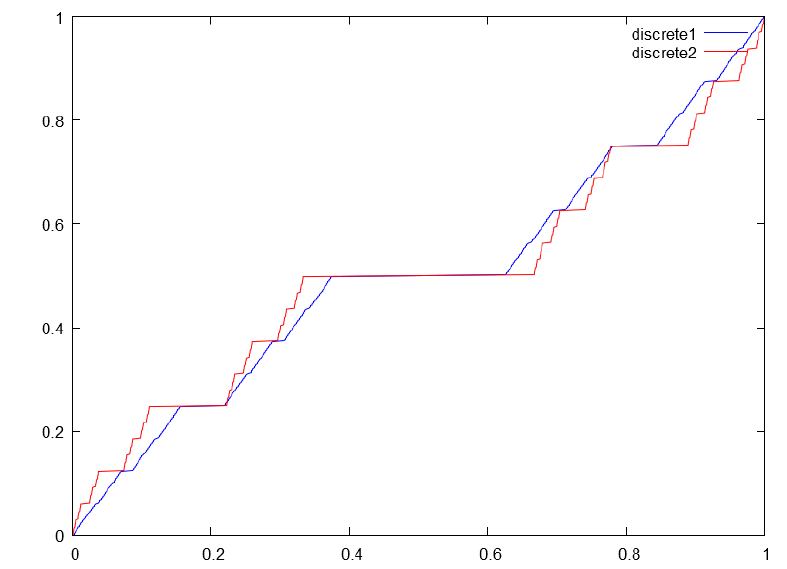
Figure 2. Approximations of the SVC (Smith-Volterra-Cantor) and Cantor’s functions. Blue (discrete1)—SVC function, red (discrete2)—Cantor’s function; both functions are computed for six levels of